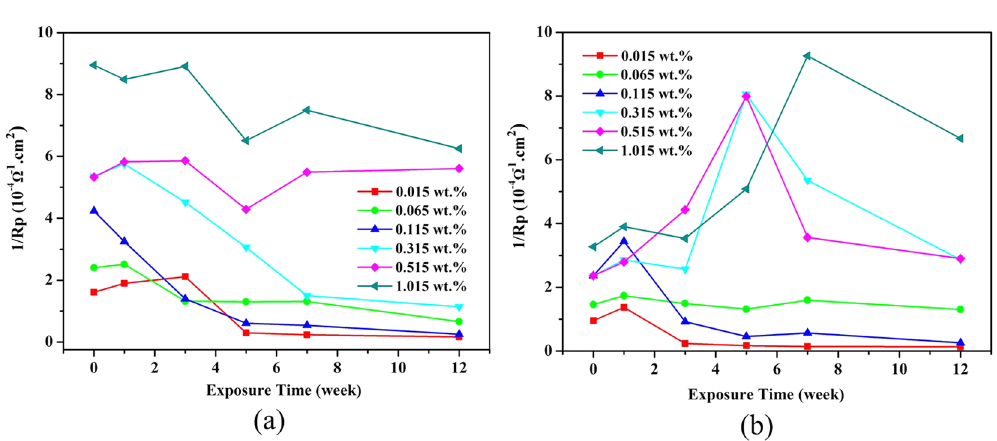
Figure 9. The variation of 1/ R p of ductile iron ( a ) and carbon steel ( b ) in soils with different levels of